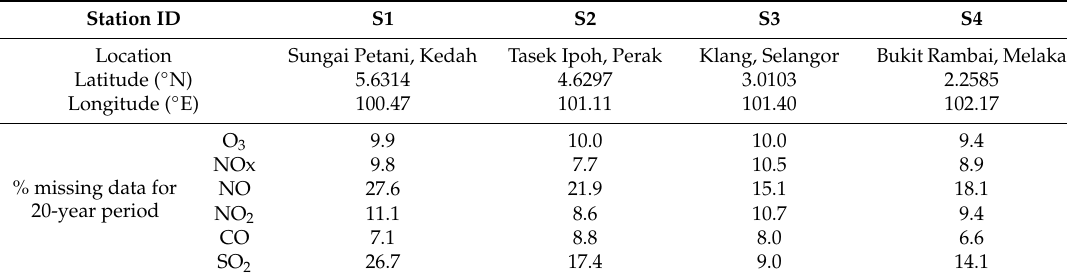
Table 1. Station location and data